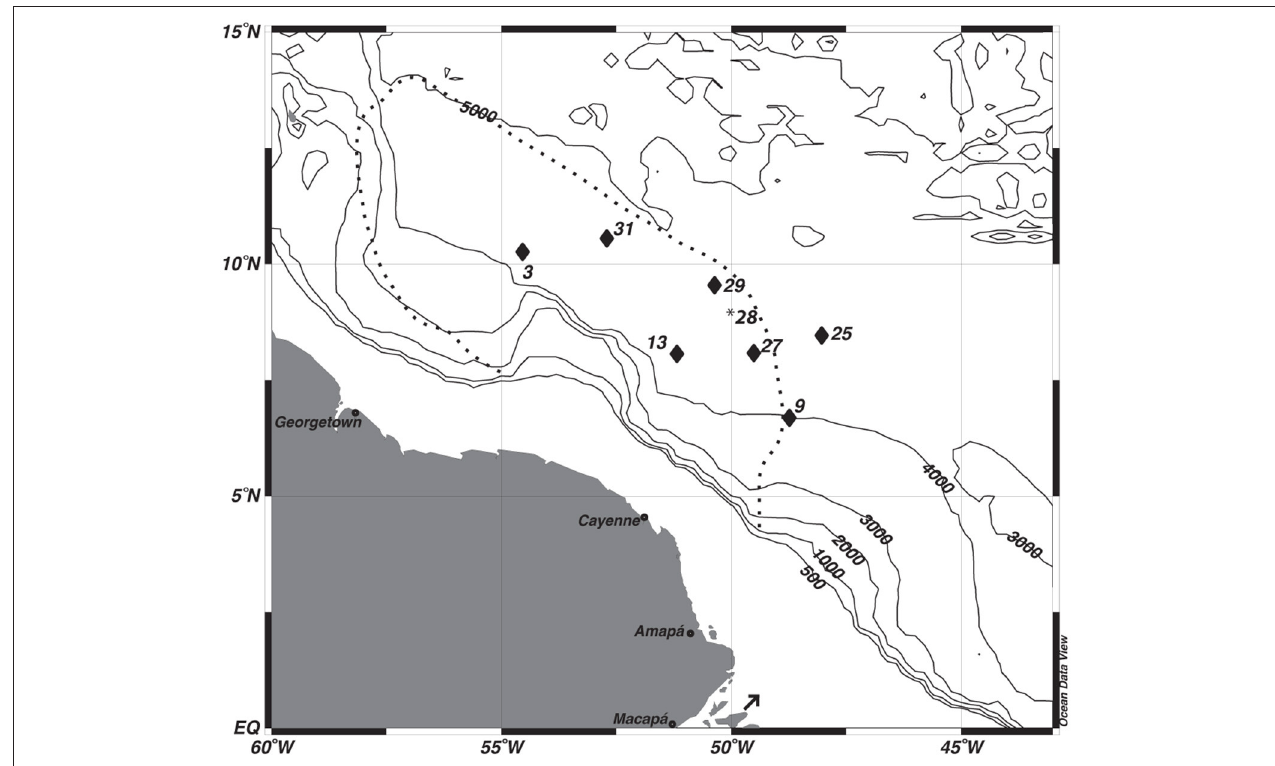
FIGURE 1 | Map of study sites. *The multi-core data from station 28 was used to correct the depth assignments of the gravity core from station 29. The dashed line depicts the general location of Amazon River Plume during peak outflow. The arrow indicates the location of the Amazon River mouth.